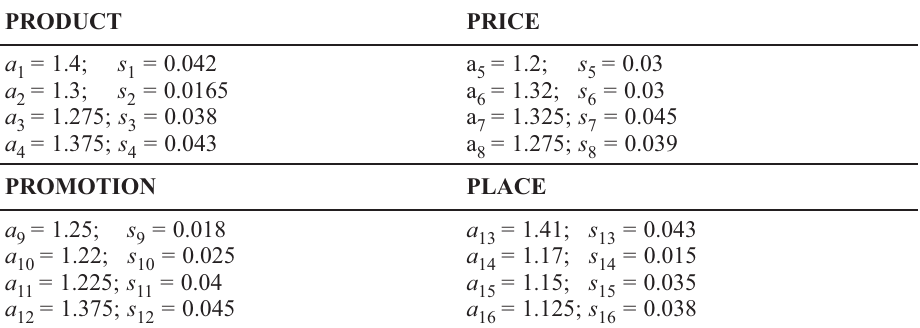
Table 2. Marketing 4P structure of expert valuations according to the effect of unit